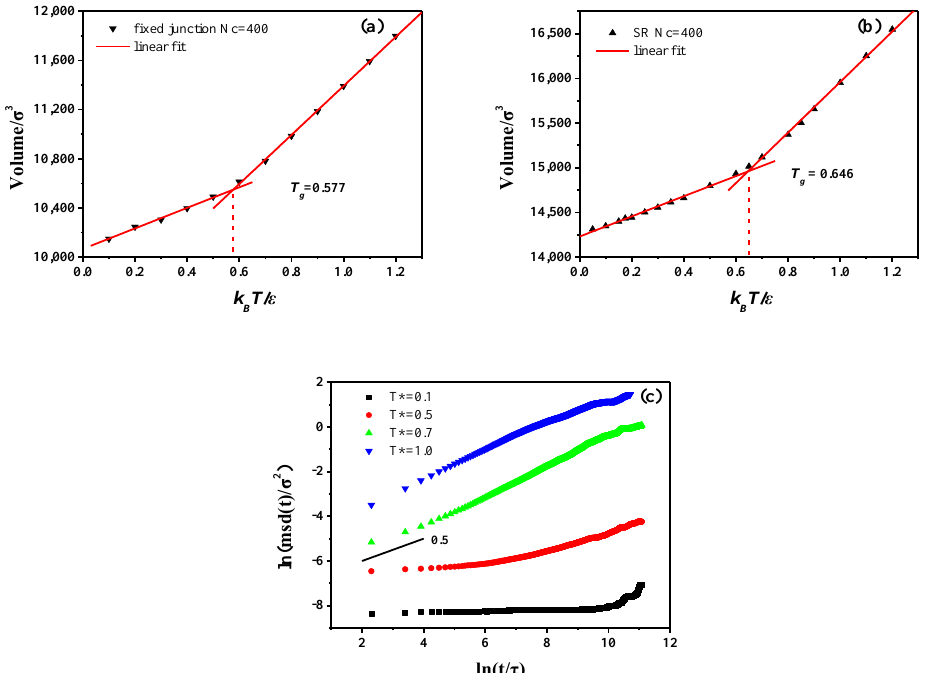
Figure 5. Temperature dependence of the volume figuring out the glass-transition temperature “volumetric T g ”of the ( a ) fixed junction system when Nc = 400 and ( b ) SR system when Nc = 400. The red lines represent the linear fitting curve. ( c ) The mean-square displacement (MSD) of backbone in fixed junction systems ( Nc = 400) at different temperatures. Notably the “dynamic T g ” of this system is around 0.6.